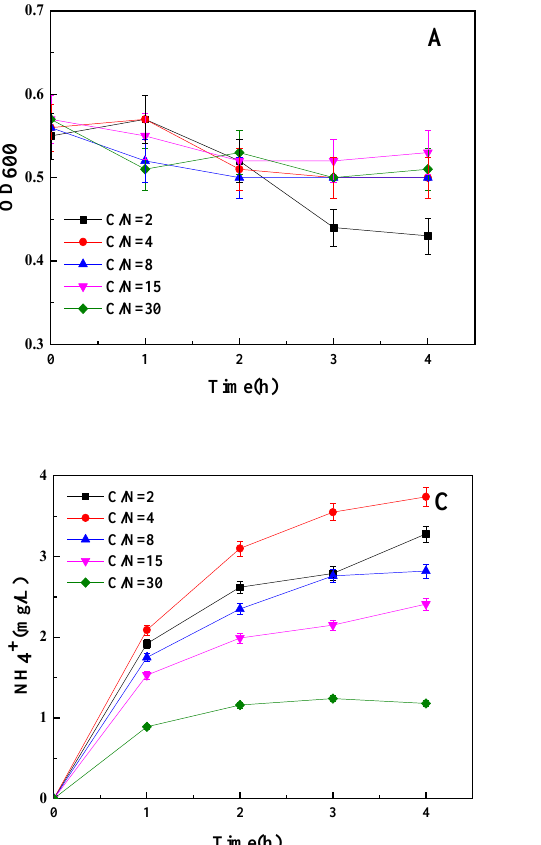
Figure 3. Influence of C/N ratio on OD 600 ( A ), NO 2 − ( B ), NH 4+ ( C ), and TN ( D ) by strain Y-9. Values are means ± SD for triplicates. Different letters indicate significant differences between treatments at p < 0.05.